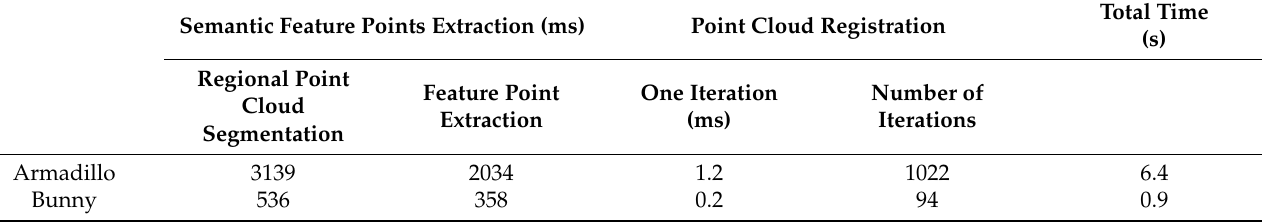
Table 2. Time performance of the proposed method.